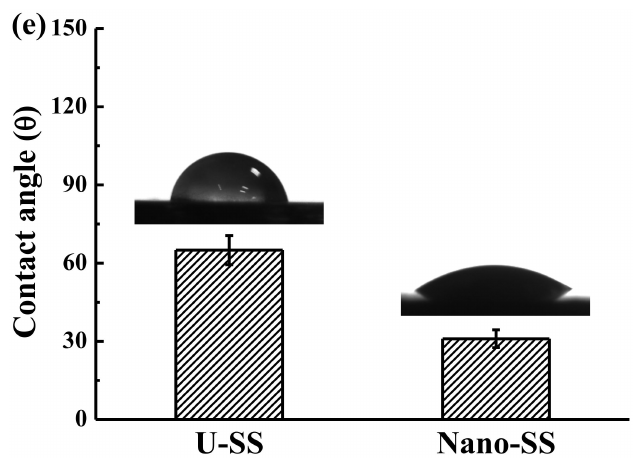
Figure 3. Characteristics of the U-SS and Nano-SS samples: ( a ) SEM micrographs, ( b ) a higher magnification of SEM micrograph which taken from the white circle area in ( a ), ( c ) XRD patterns, ( d ) AFM images, and ( e ) wettability evaluation.